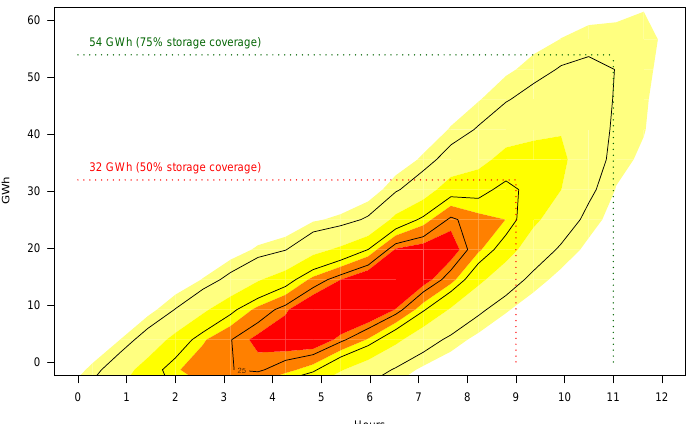
Figure 12. A bivariate kernel density plot of stored energy (GWh) and duration (h) for a storage asessment based on computed surplus slacks from the optimization Model (1). The black curves correspond to 25, 50 and 75% densities. The color grades are 20, 40, 60 and 80%